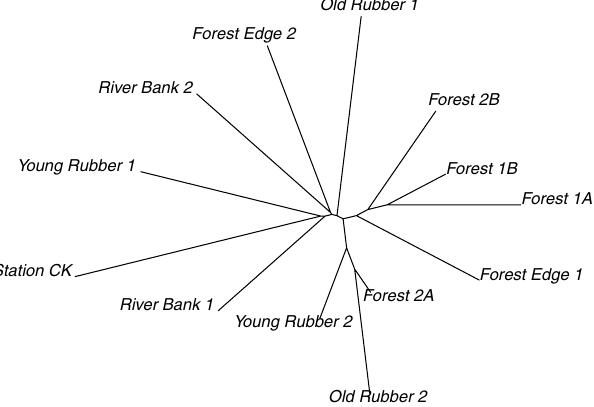
Figure 6. Neighbour joining phenogram depicting differences in phylogenetic community structure of bees between sample locations. The distance between a pair of locations is calculated from phylogenetic distances between their taxa, and weighted by taxon abundances.